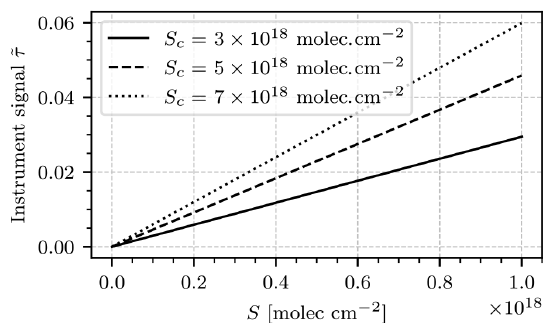
Figure 4. The modeled instrument signal ˜ τ = ln (cid:0) J c · J ref / (cid:0) J · J c, ref (cid:1)(cid:1) as a function of the target gas col- umn density S for different choices of cell column density S c . The instrument response is almost perfectly linear in S . The slope of each line yields the instrument calibration corresponding to S c